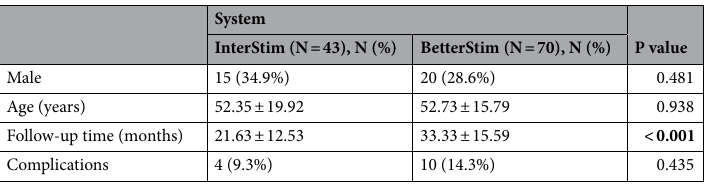
Table 1. Baseline information. Significant values are in bold.